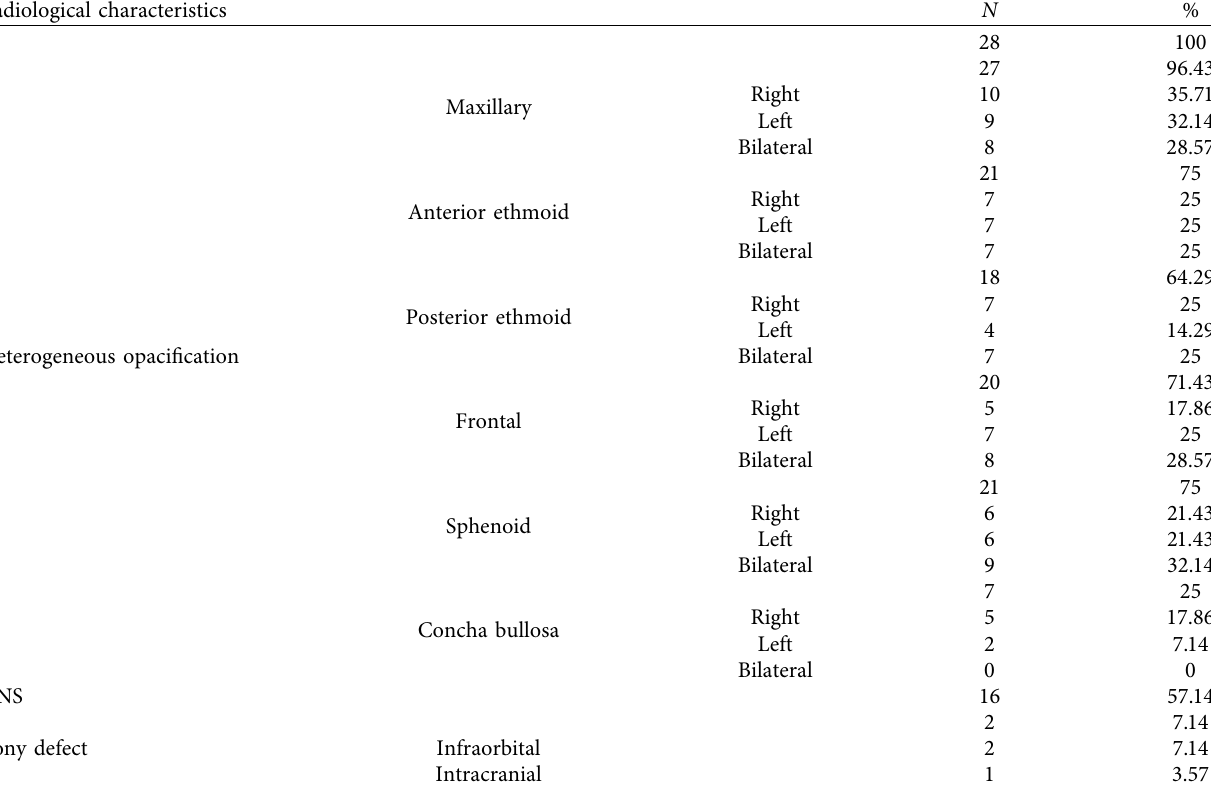
Table 3: Radiological characteristics of the first CT